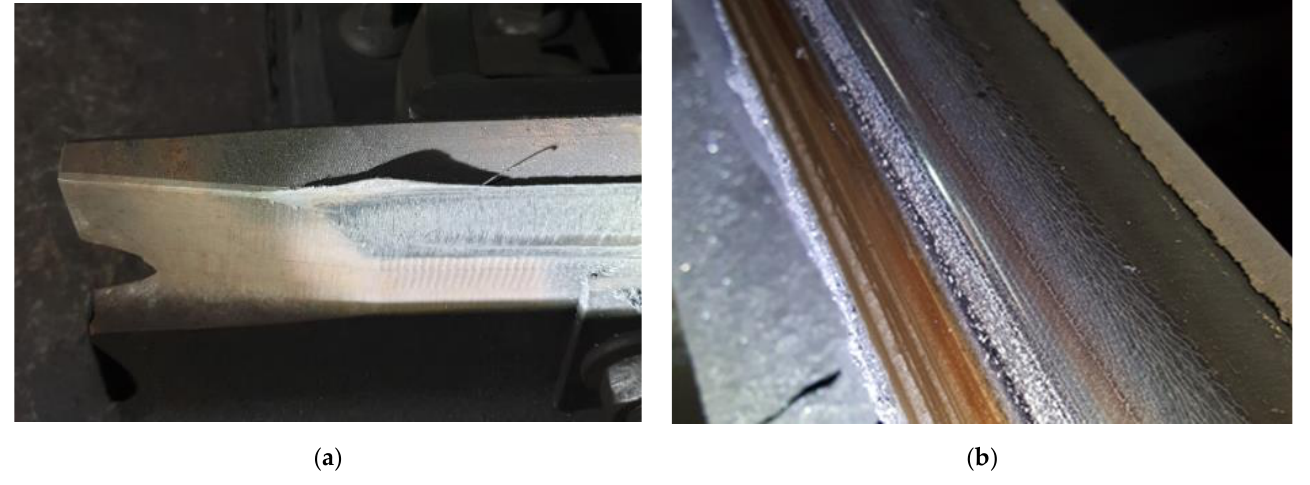
Figure 8. Wear in check rail and closure rail of turnout system: ( a ) check rail wear and ( b ) closure rail side wear.